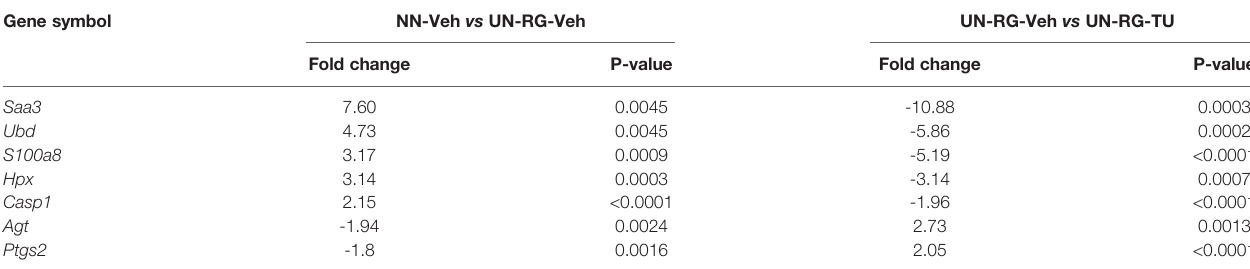
TABLE 3 | List of genes of interests